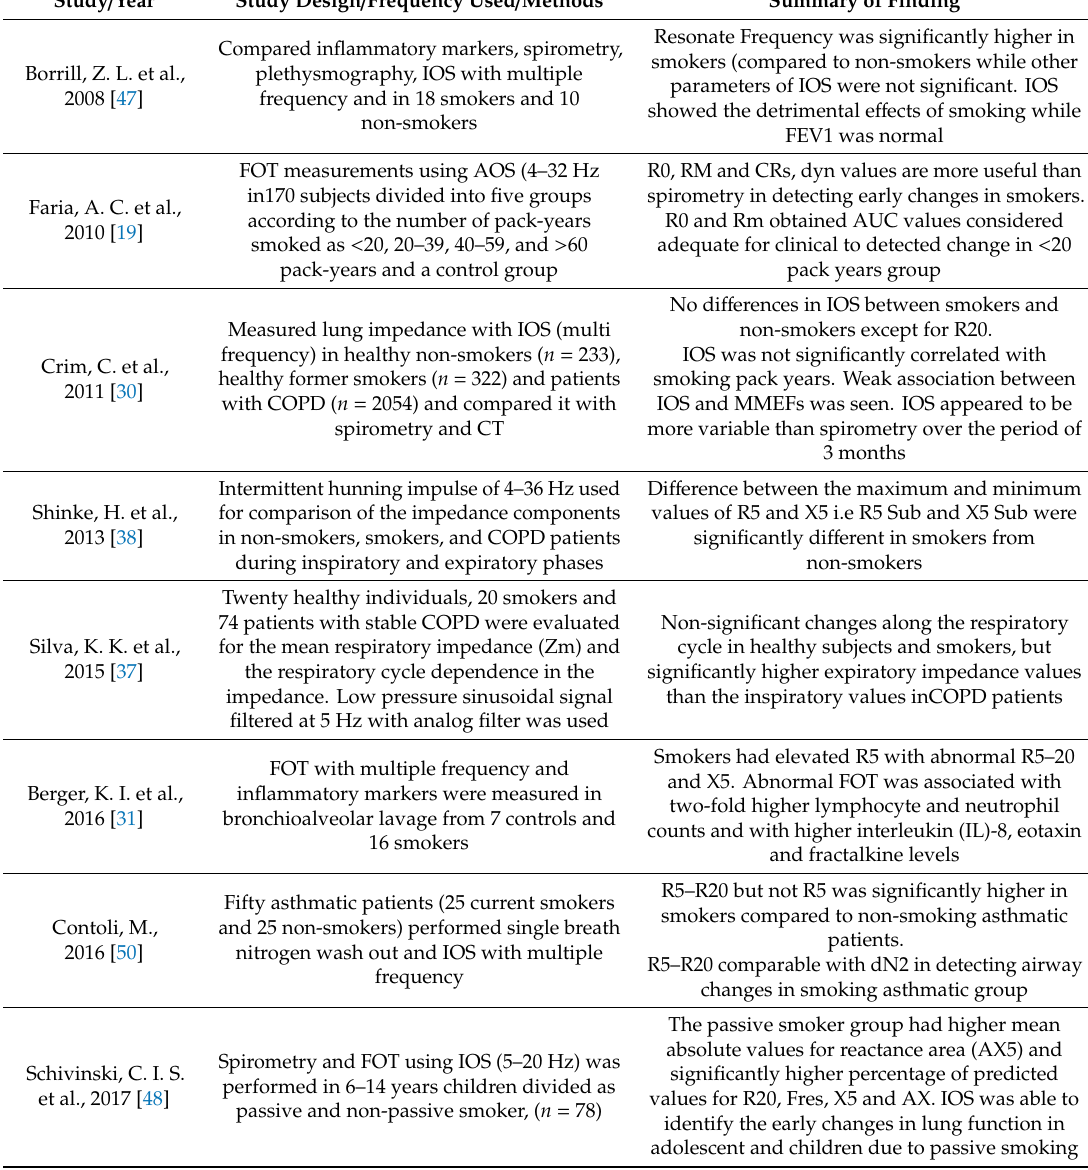
Table 1. Summary table of the studies using Forced Oscillation technique (FOT) to detect early respiratory changes in